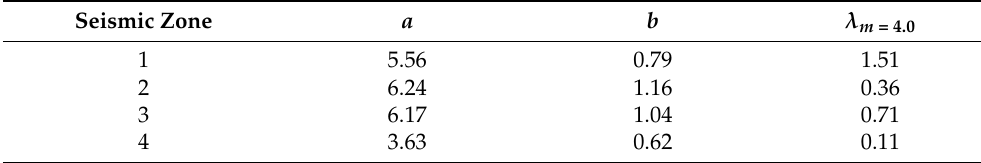
Table 3. Gutenberg–Richter recurrence rate parameters for each seismic zone.